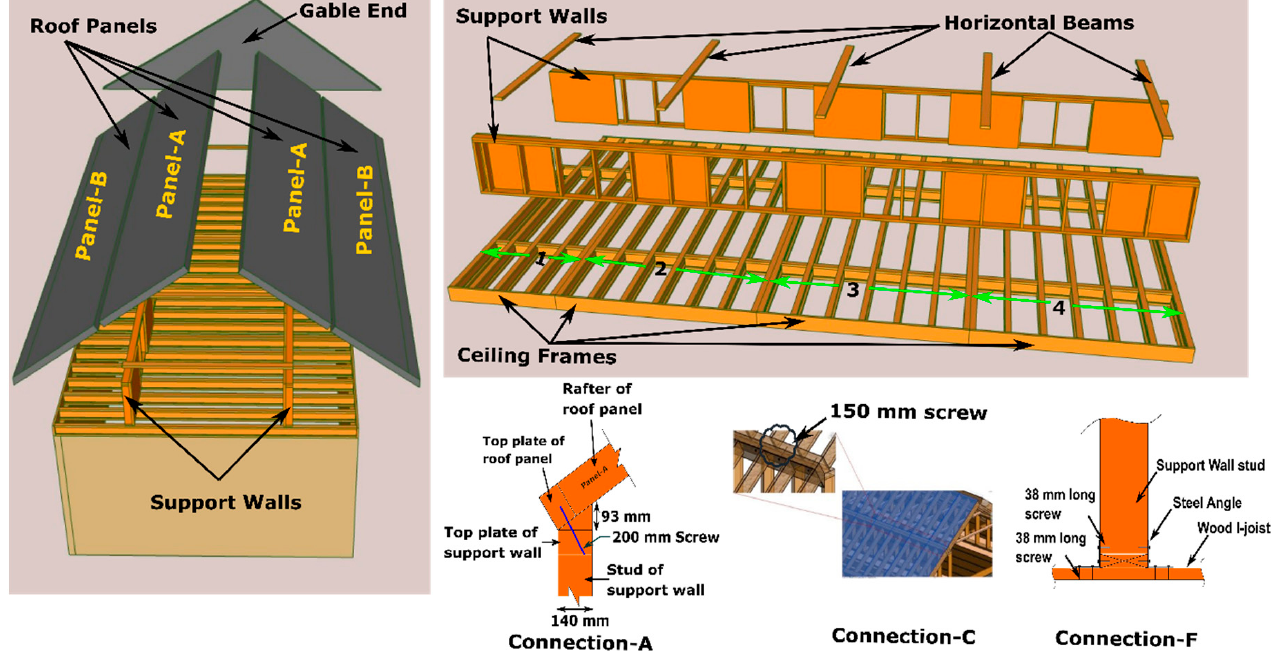
Figure 3. Panelized roof concept.